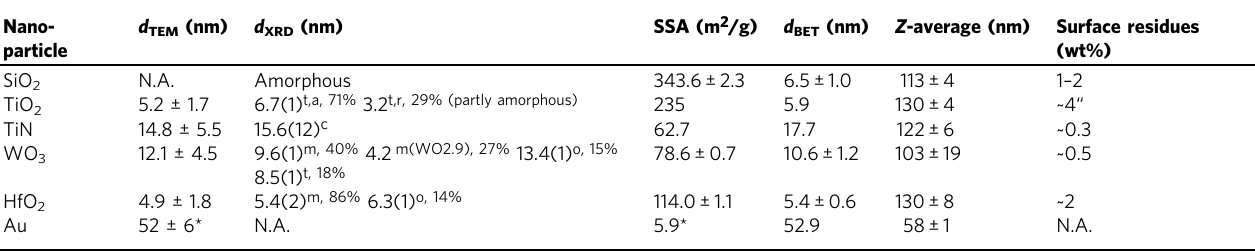
Values are displayed as the mean±standard deviation (SD) or mean with last digits of the estimated SD (ESD) in brackets; XRD crystal phases: a: anatase, c: cubic, m: monoclinic, o: orthorhombic, r: rutile, t: tetragonal. *According to the analysis certi fi cate of the supplier; “ can be further reduced to <0.5% by post-annealing. The nanoparticle primary particle sizes ( d TEM ) were extracted from TEM data by analyzing the diameter of n = 211 (TiO 2 ), n = 247 (TiN), n = 195 (WO 3 ), and n = 275 (HfO 2 )